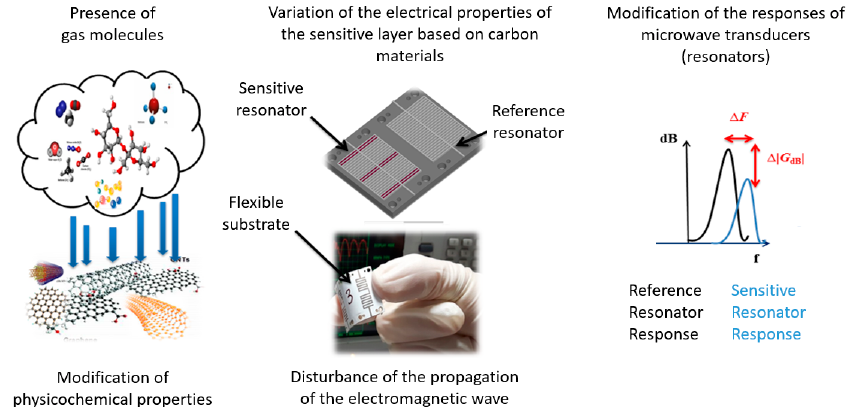
Figure 1. Overview of the operating principle of the differential microwave chemical gas sensor.